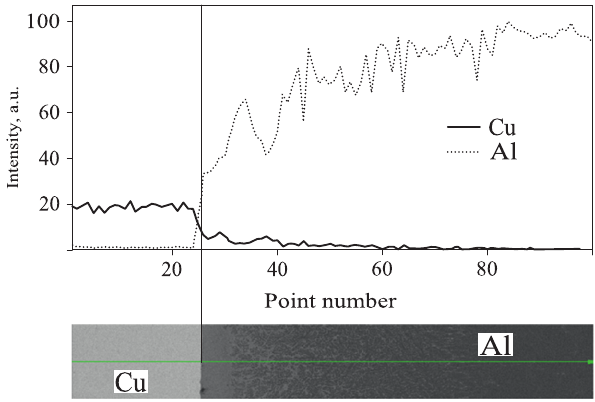
Figure 2: Line scanning results of Cu and Al in the transition layer.